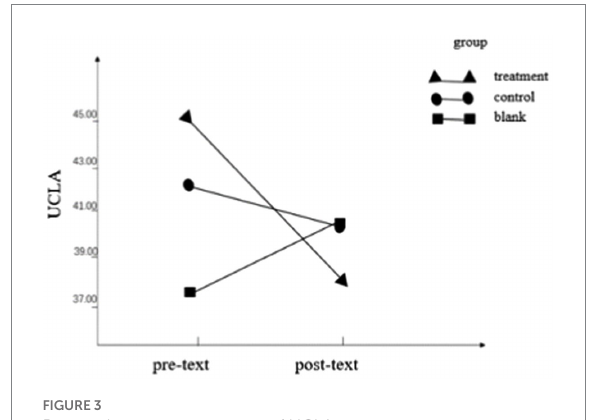
FIGURE 4 Pre- and post-text outcome of